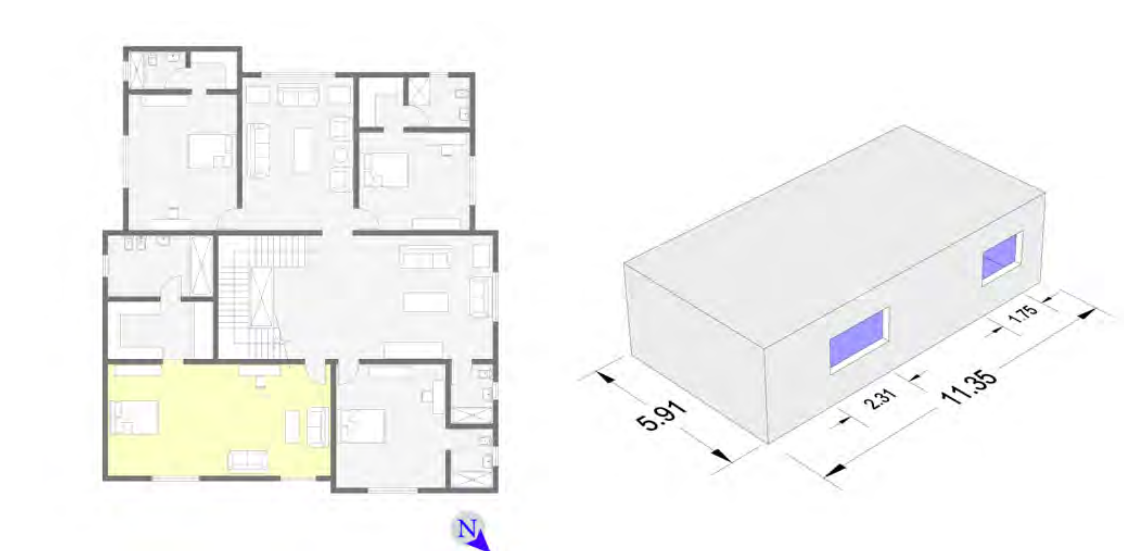
Figure 5. Layout of the residential unit and the master bedroom marked in yellow (left), the geometric model for the master bedroom (right)